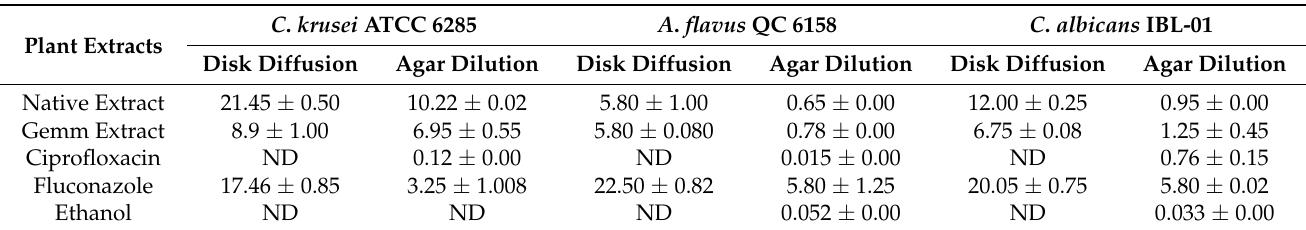
Table 4. Antimicrobial activity of native and gemm extracts of H . griffithi expressed as MIC ( µ g/mL) determined by disk diffusion and agar dilution methods against fungal strains. Plant